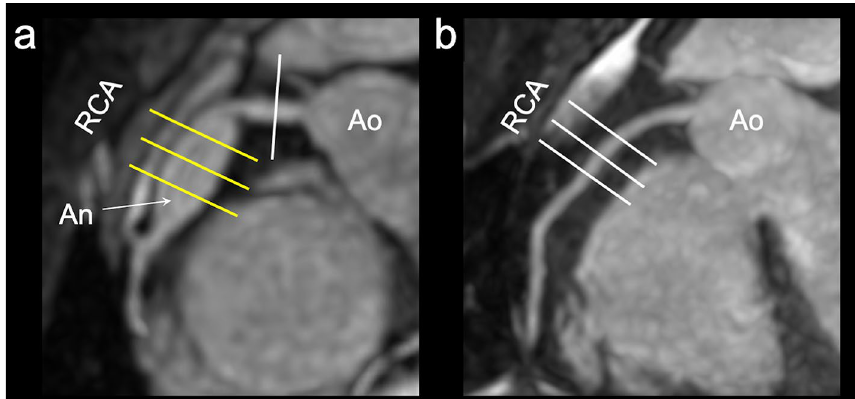
Figure 1. Slice setting. The white lines indicate normal regions, and the yellow lines indicate aneurysmal regions. The magnetic resonance angiography (MRA)-collapsed partial maximum intensity projection (MIP) image demonstrates the right coronary artery (RCA) in case 7 ( a ). For aneurysms, the basic settings were three cross-sections: center, proximal, and distal portions ( a ). The MRA-collapsed partial MIP image demonstrates the RCA in case 8 ( b ). In the follow-up examination of aneurysm regression, the previous aneurysm regression was regarded as a normal part, and cross-sectional images were continuously obtained ( b ) ( An aneurysm, Ao